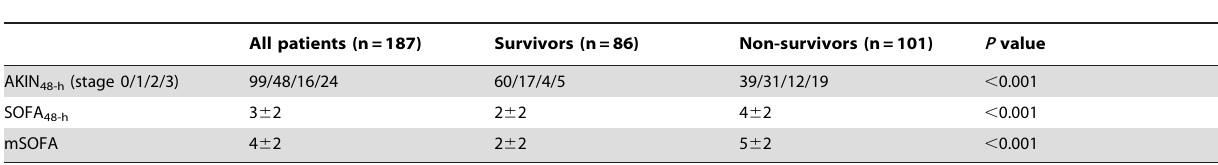
Table 4. Comparison of AKIN and SOFA scores between survivors and non-survivors